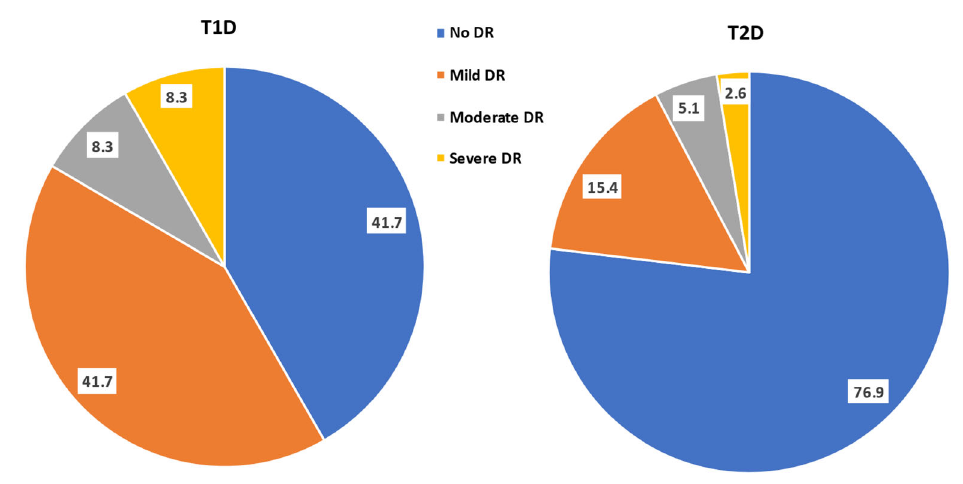
Figure 1. Pie chart (percentage frequency distribution) of the grades of diabetic retinopathy in the studied population having type 1 and type 2 diabetes mellitus (T1D and T2D).